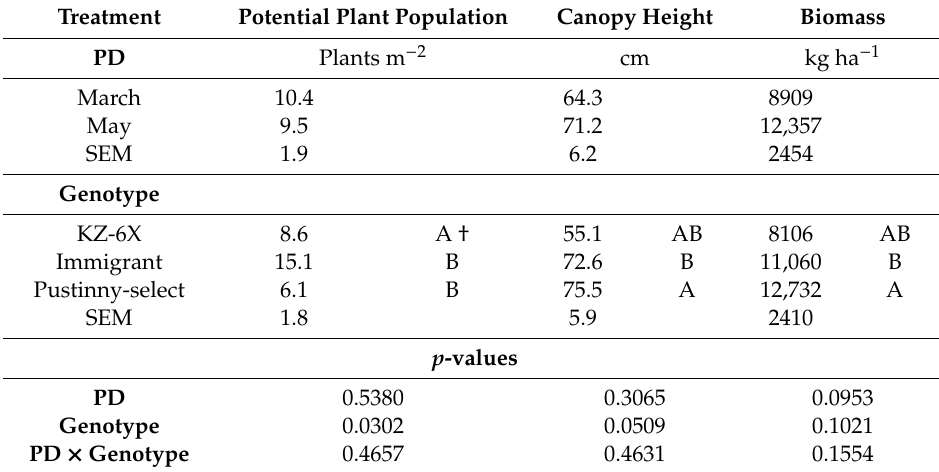
Table 3. Planting date (PD) and genotype e ff ects on potential plant population, canopy height, and biomass of Bassia prostrata (L) A.J. Scott genotypes sown in 2014 at Tucumcari, NM, USA, and estimated from a 0.5 m 2 area within an area of dense stand ( ≥ 50% canopy cover) in 2018. Data are the lsmeans of three